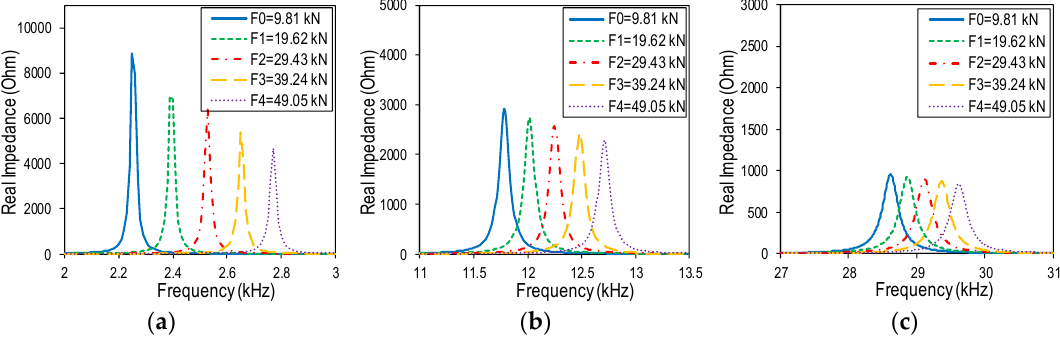
Figure 9. Shifts in numerical impedance peaks due to tension force changes: ( a ) Peak 1; ( b ) Peak 2; ( c ) Peak 3.